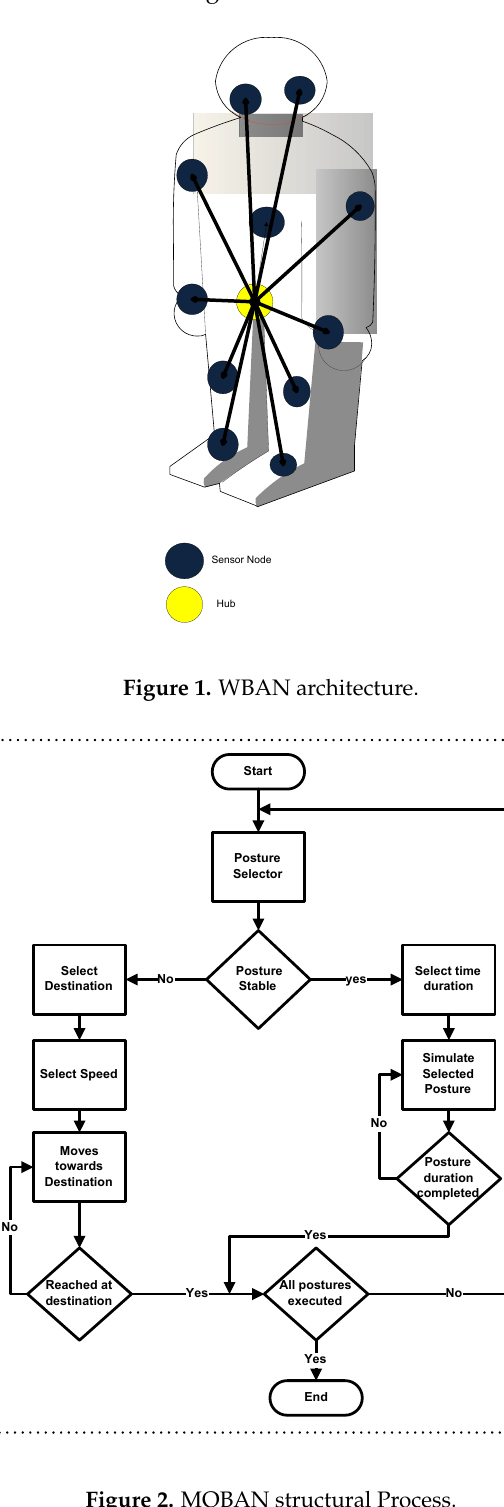
Figure 2. MOBAN structural